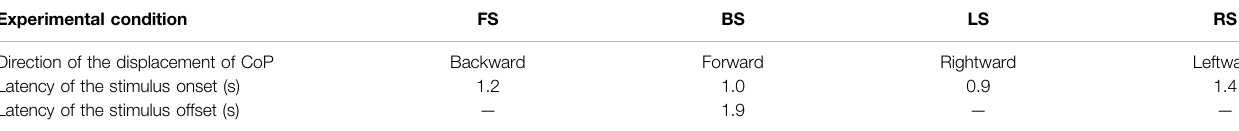
TABLE 4 | Latency of the stimulus onset and offset of the displacement of CoP. “ - ” means that the latency is more than 5s. Experimental condition Direction of the displacement of